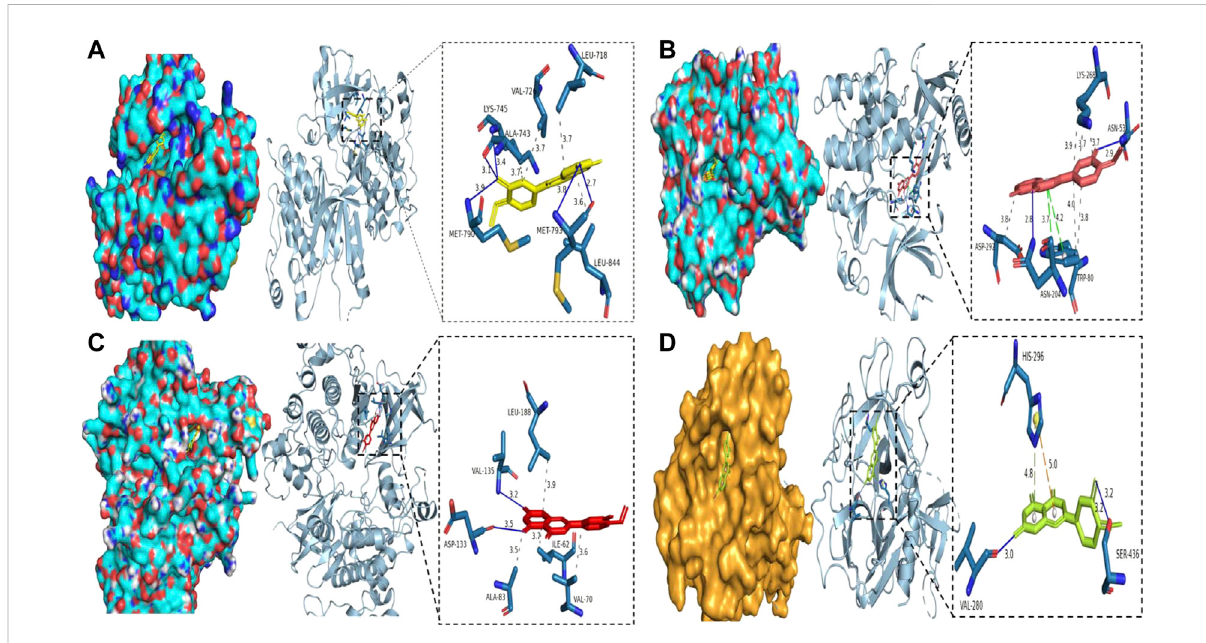
FIGURE 10 Binding of Diosmetin to COVID-19/BRCA and the core targets EGFR, AKT1, GSK3B using molecular docking analysis. (A) Diosmetin and the EGFR protein 6TG0 form hydrogen bonds on LYS-745, MET-790, ALA-743, and MET-793, with hydrophobic bonds on LEU-718, ALA-743, and VAL- 726. (B) Diosmetinand AKT1 protein 7NH5 form hydrogen bonds on ASN-53 and ASN-204, with hydrophobicbondson ASP-292, TRP-80, and LYS- 268, and π bonds on ASN-204 and TRP-80. (C) Diosmetin and GSK2B protein 6Y9S form hydrogen bonds on VAl-135 and ASP-133, with hydrophobicbondsonLEU-188,ALA-83, ILE-62,and VAL-70. (D) TheDiosmetinand COVID-19 protein7MEQ formsahydrogenbond onVAL-280 and SER-436, with a cation interaction on HIS-296 and a π bond on